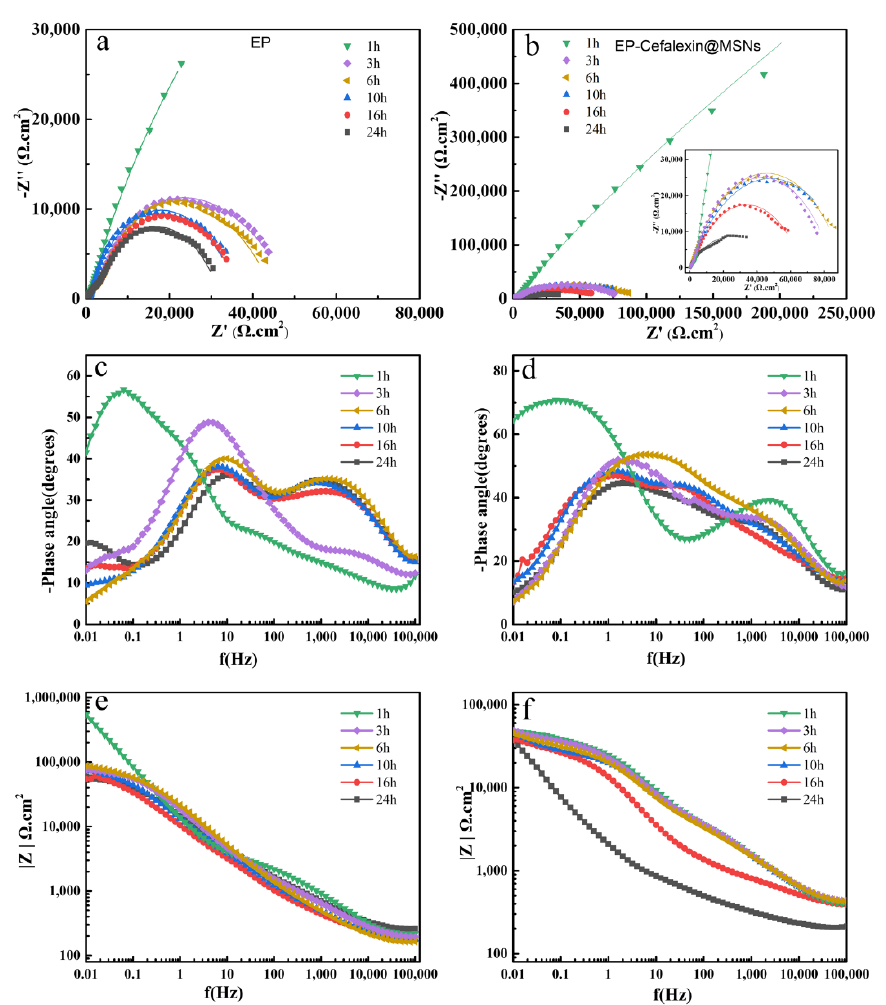
Figure 5. Nyquist and Bode plots of EP ( a , c , e ) and EP-Cefalexin@MSNs ( b , d , f ) after being immersed in 3.5 wt% NaCl solution for different durations.